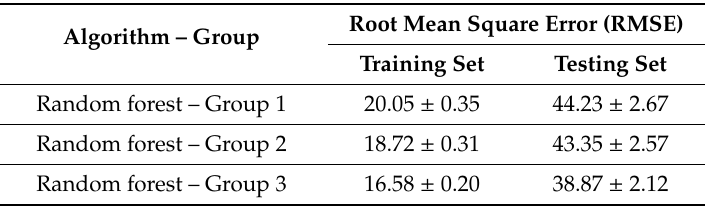
Table 10. Root mean square error (mean ± standard deviation) of annual EUI for training and testing sets of three groups of predictors (Figure 3) used in the Random Forest